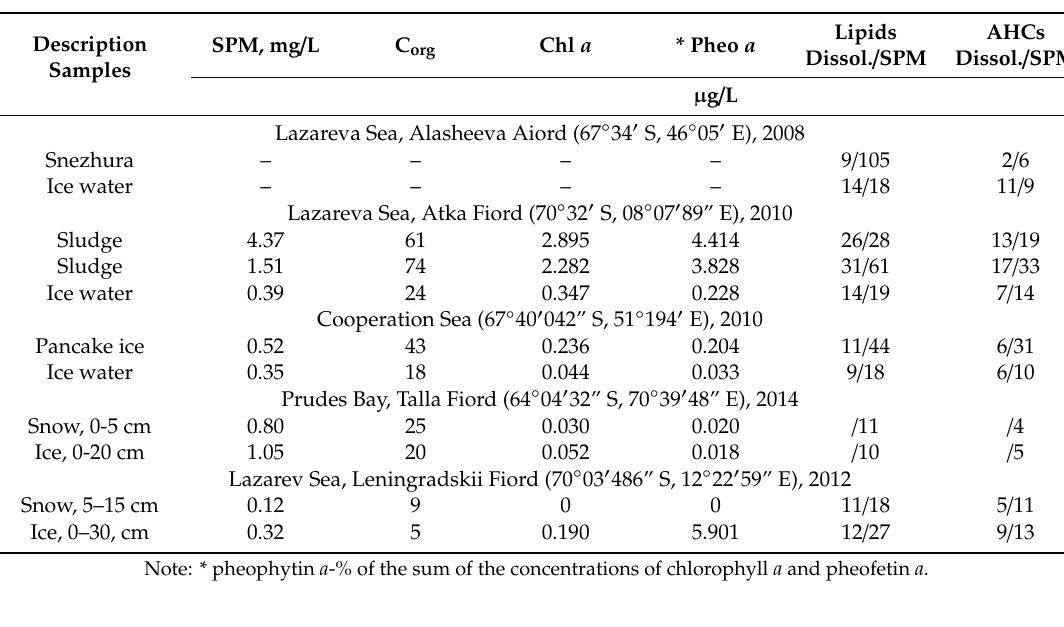
Table 2. The concentration of SPM and OCs in the fast snow-ice cover.